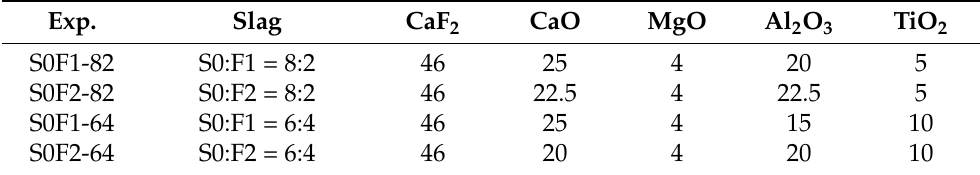
Table 2. Chemical composition of slag consisting of S0 and F1(F2) used in slag-metal reaction